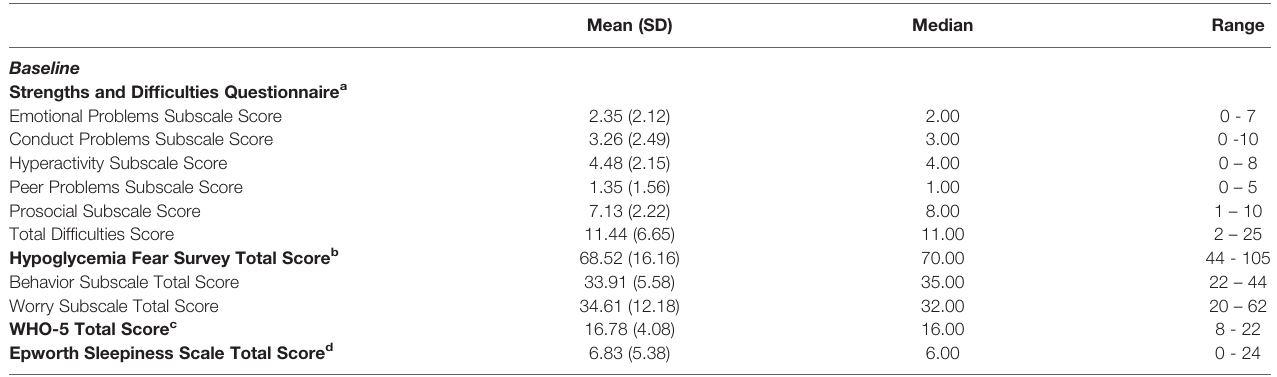
TABLE 1 | Descriptive statistics (Mean, Standard Deviation, Median, Range) for scales used in the